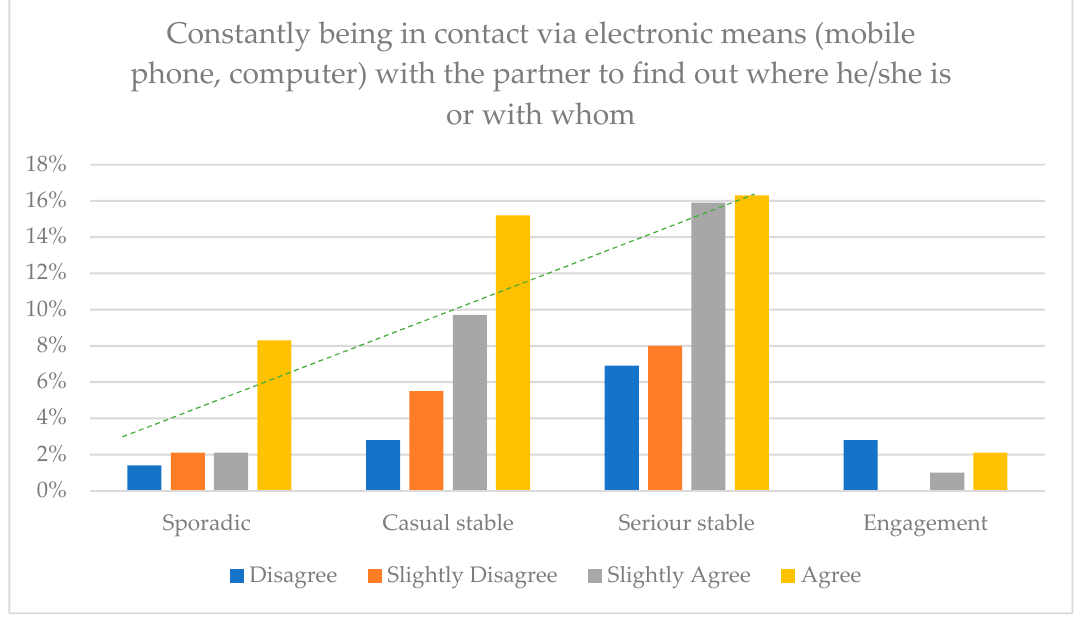
Figure 1. Results of item 7 correlated with the type of affective–sexual relationship.